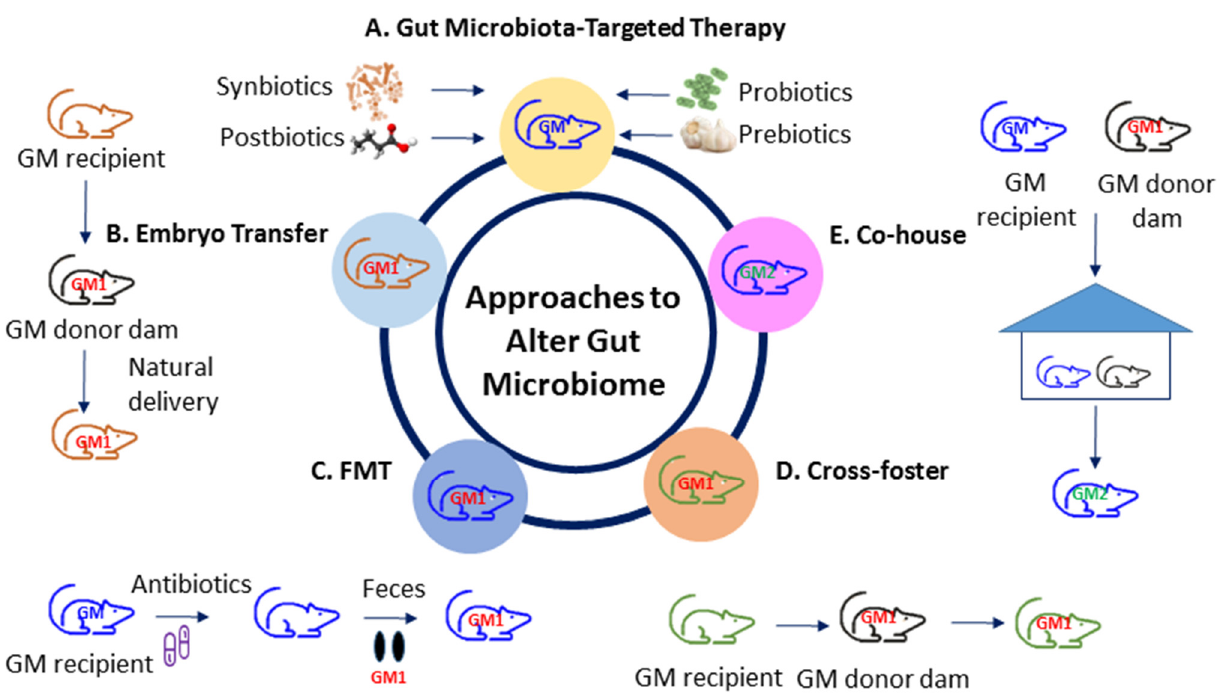
Figure 2. Different approaches to altering the gut microbiota. ( A ) Gut microbiota-target therapy; ( B ) embryo transfer; ( C ) fecal microbiota transfer; ( D ) cross-foster; ( E ) co-house. FMT = fecal microbiota transfer; GM = gut microbiota; GM1 = transferred gut microbiota; GM2 = GM + GM1.